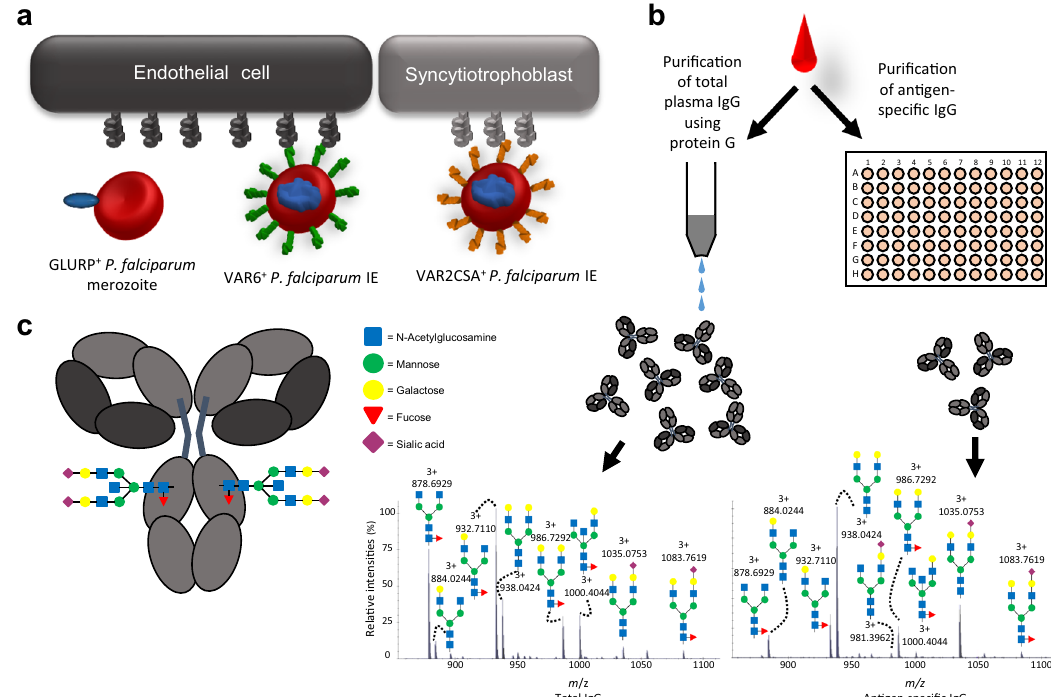
Fig. 1 Background and study work fl ow. a IgG1 speci fi c for the merozoite antigen GLURP and two members of the PfEMP1 family expressed on the surface of IEs were analyzed in this study. Most PfEMP1 variants facilitate sequestration of IEs to vascular endothelium (exempli fi ed here by VAR6), while VAR2CSA-type PfEMP1 mediate IE sequestration in the placental syncytiotrophoblast and intervillous space. b Plasma samples were split and used to purify total plasma IgG1 and antigen-speci fi c IgG1, using protein G-coupled sepharose and solid-phase absorption with recombinant antigens, respectively. Eluted IgG1 was digested with trypsin and the glycopeptides analyzed by liquid chromatography mass spectrometry (LC-MS). Examples of MS spectra of total IgG1 (left) and antigen-speci fi c (anti-VAR6) IgG1 (right) from one sample is shown. c The fractions of the different glycosylation traits of the Fc glycan depicted were calculated from LC-MS